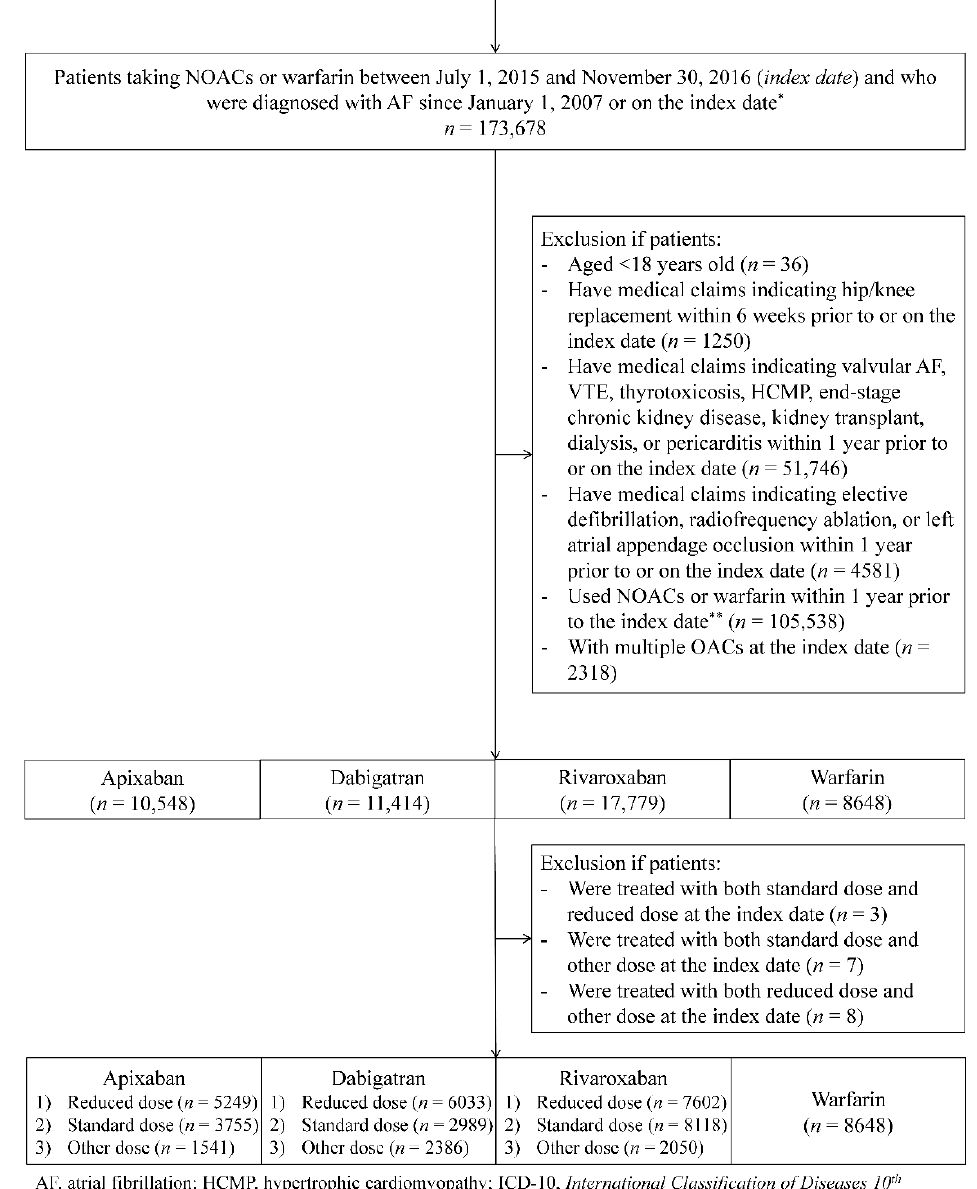
Figure 1. Cohort creation flow of oral anticoagulant